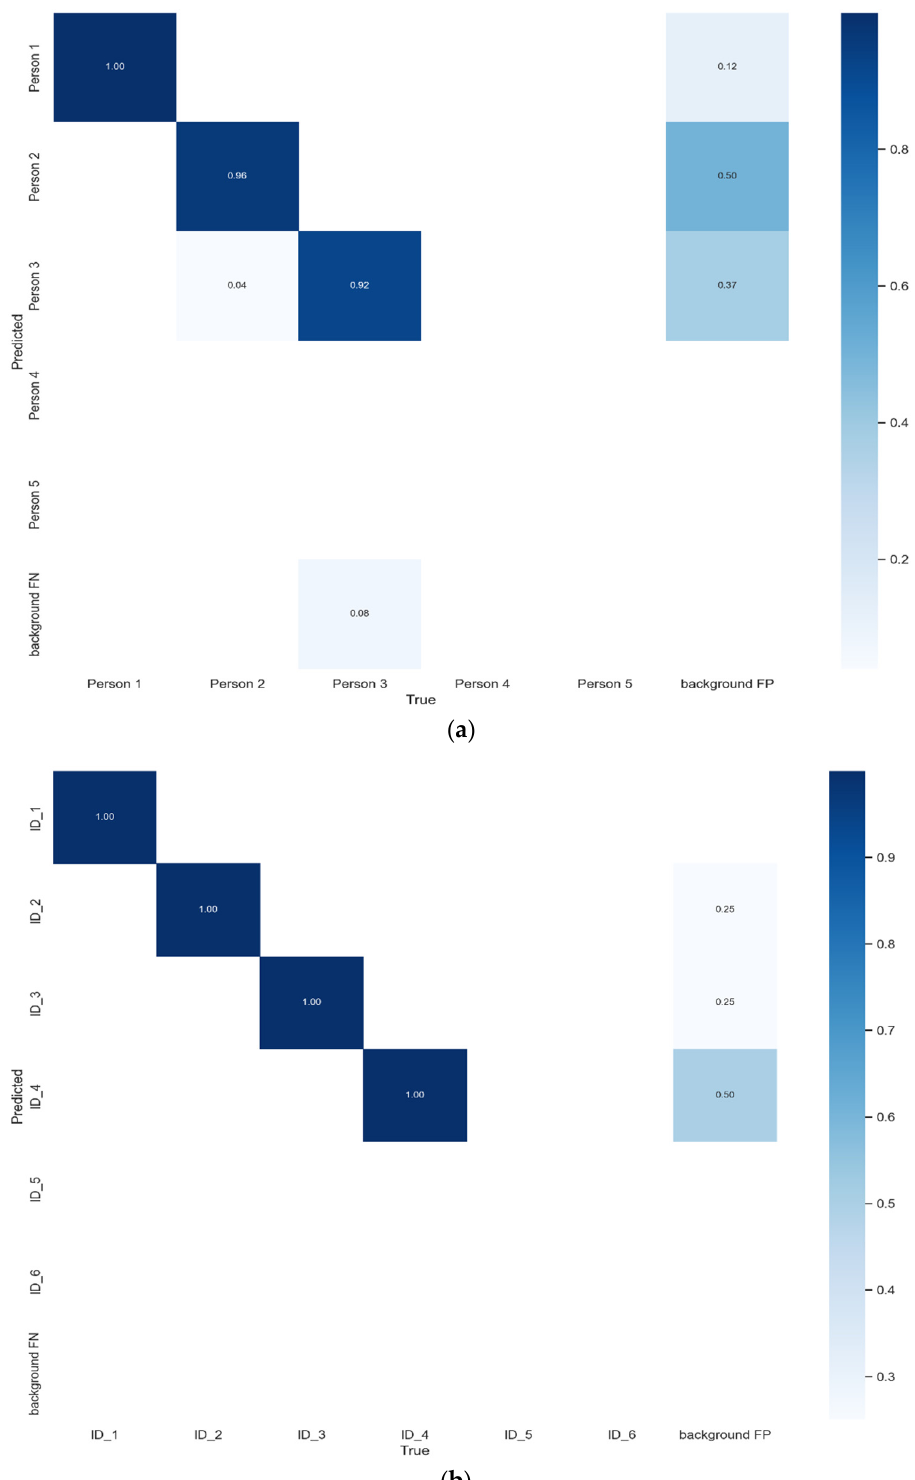
Figure A1. Illustrate the confusion matrices on both ( a ) passageway sequence, and ( b ) campus sequence, respectively.